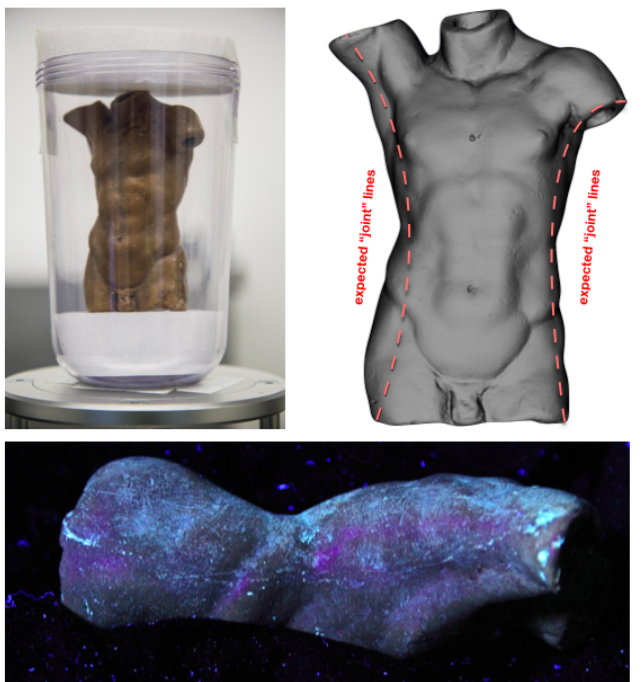
Figure 4. Sample mounted in perspex glass container on left; and a low-resolution rendering of the volume annotated with dashed lines along its side to show the expected “joint lines” on right. Bottom is one of the ultraviolet images taken of the sculpture, showing the joint line on one side; image was provided by the expert.